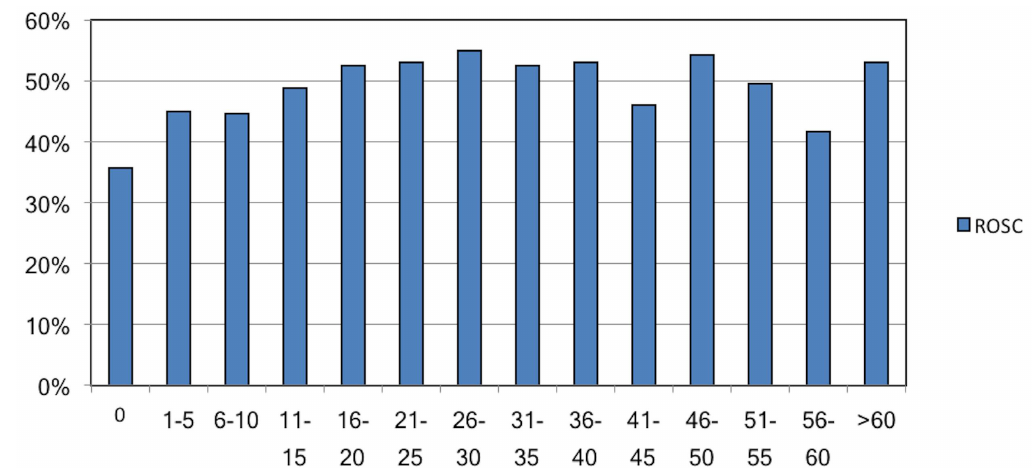
Figure. Percentage return of spontaneous circulation (ROSC) by paramedic cumulative out-of-hospital cardiac arrest (OHCA) cumulative case volume. Proportion of patients attaining ROSC by paramedic five-year OHCA case